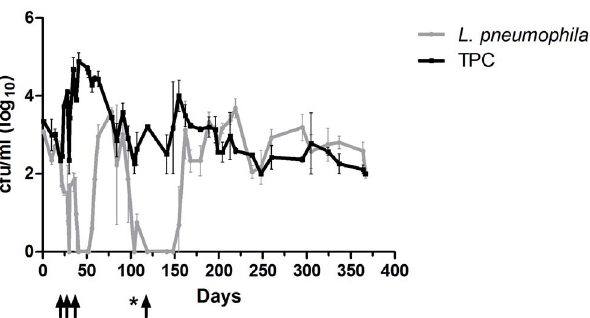
Fig. 1. Correlation between L. pneumophila sg 2–14 and TPC in the shower system of School 1 over a period of 1 year. The arrows indicate time points for hot water treatment and the star represents a one-time chlorination treatment (Concentrate of di-n-decyl dimethylammonium chloride ( , 2%), quaternary ammonium combinations, benzyl-C8-18-alkyldimetyl, chlorides ( , 2%) and hexamethylene biguanide hydrochloride ( , 1%) (Barrier Tech Concentrate)) of the system.